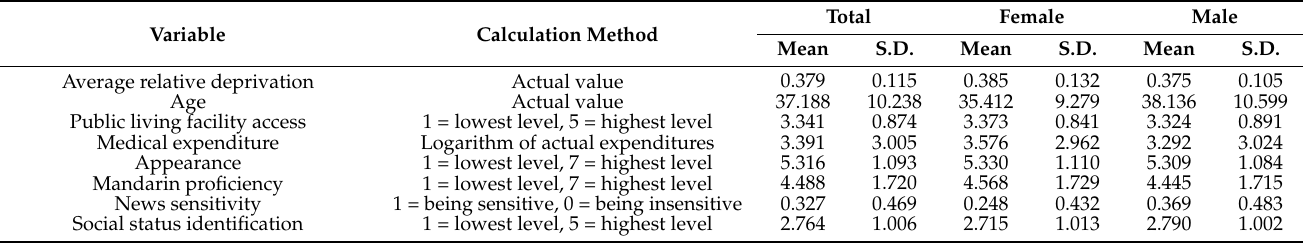
Table 4. Statistics of the